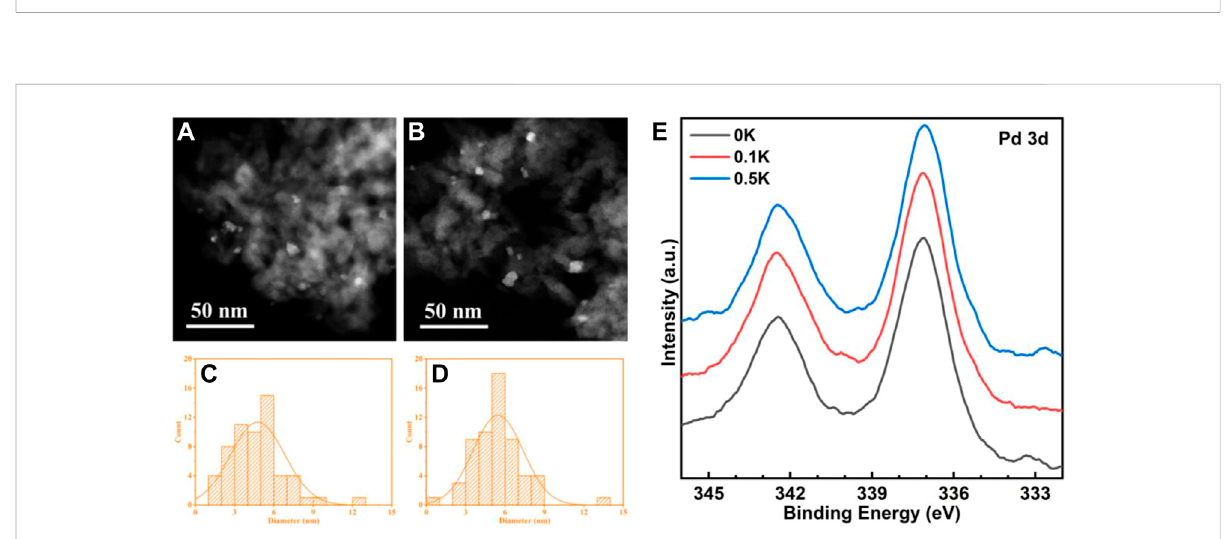
High-angle annular dark fi eld (HAADF) micrographs of 0K (A) and 0.5K (B) catalysts; (E) PdO nanoparticles size distributions of 0K (C) and 0.5K (D) . (E) Pd 3d XPS spectra of 0K, 0.1K, and